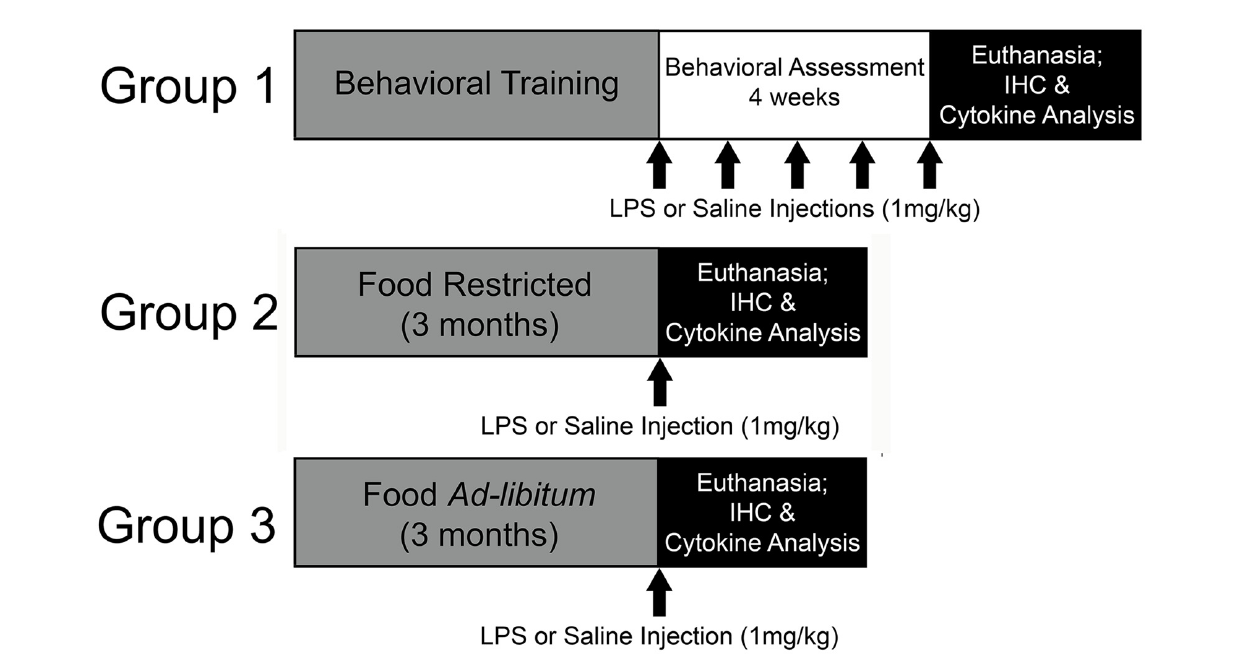
FIGURE 1 | Experimental design. In this experiment, the impact of repeated systemic inflammation on attentional function was evaluated with Group 1, a cohort of young and middle age Fischer-344 rats that were food restricted and underwent behavioral training and testing on the 5-choice serial reaction time task (5-CSRTT). Once they reached criterion on the task they received injections of saline or lipopolysaccharide (LPS; 1 mg/kg, i.p.) once a week for 4 weeks while their attention was evaluated. They were injected once more 48 h prior to euthanasia. To examine the potential modifying effects of food restriction on inflammatory responsivity, two cohorts (Group 2 and 3) were either food restricted or maintained with full access to food for 3 months, which aligns with the average length of time for 5-CSRTT behavioral training. They were then injected with saline or LPS 48 h prior to euthanasia and tissue was collected for cytokine analysis and immunohistochemistry